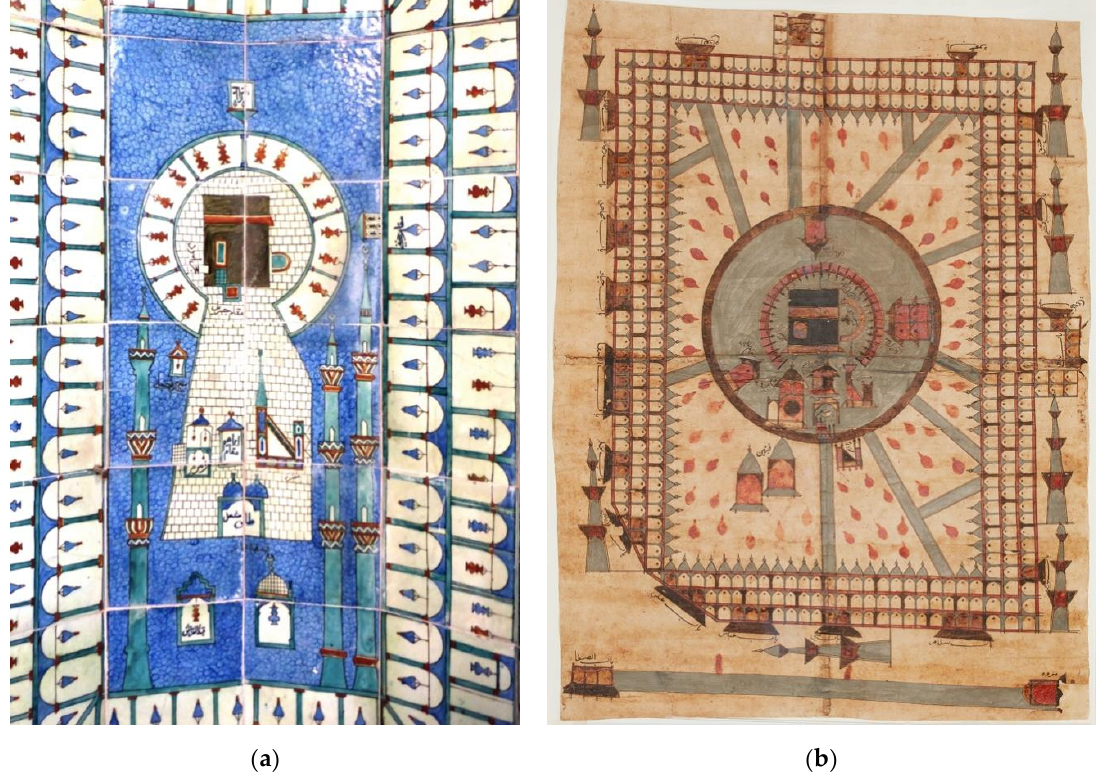
Figure 7. ( a ) Mihrab in Topkapi Palace, photo of the author, Istanbul, 2020; ( b ) Memorial scroll of pilgrimage, Saudi Arabia, probably Mecca/Hijjaz, late 18th century paper; watercolor and